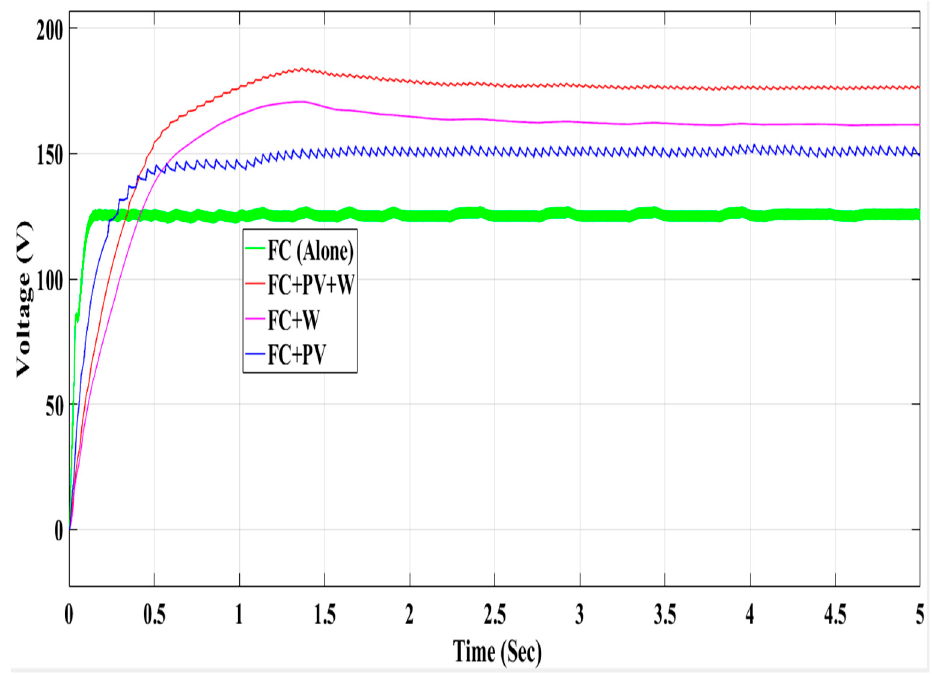
Figure 32. Comparative characteristics of voltage in the FC, FC–PV, FC–W, and FC–PV–W models using the P&O controller.